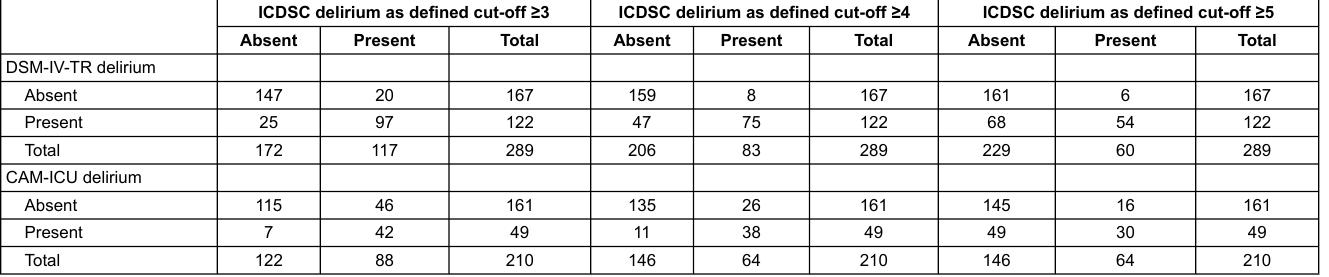
Table 2: Allocation of the absence and presence of delirium as defined by ICDSC cut-off score from ≥3 to ≥5 versus the DSM-IV-TR-defined diagnosis of delirium or the CAM- ICU. ICDSC delirium as defined cut-off ≥3